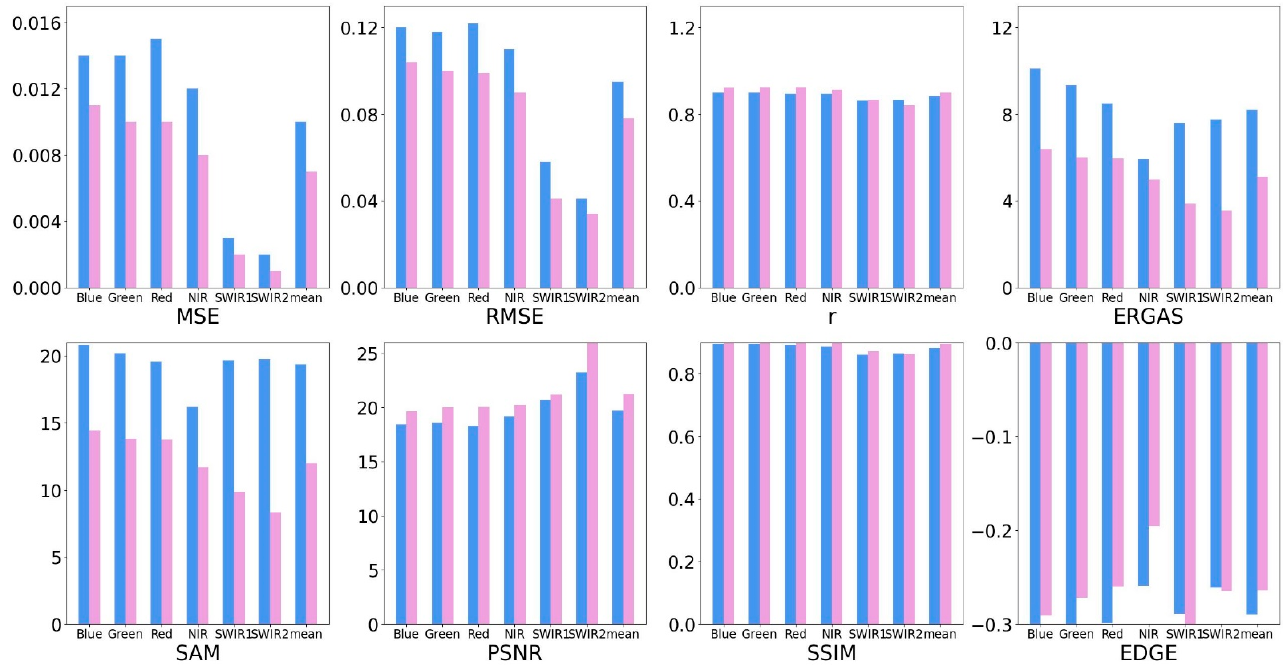
Figure 8. The accuracy evaluation results for ESTARFM and iESTARFM. The blue bars represent the result of the ESTARFM method, and the pink bars represent the result of the iESTARFM method.